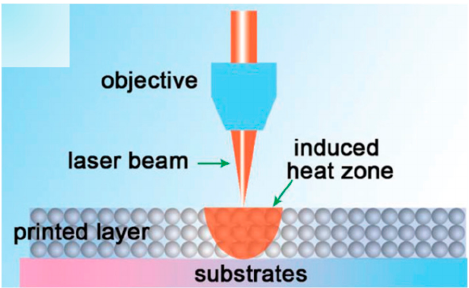
Figure 9. Scheme of laser sintering principle: a focused beam locally heats the printed Ag NPs layer. Reproduced with permission from [32]; Copyright 2017 Royal Society of Chemistry.